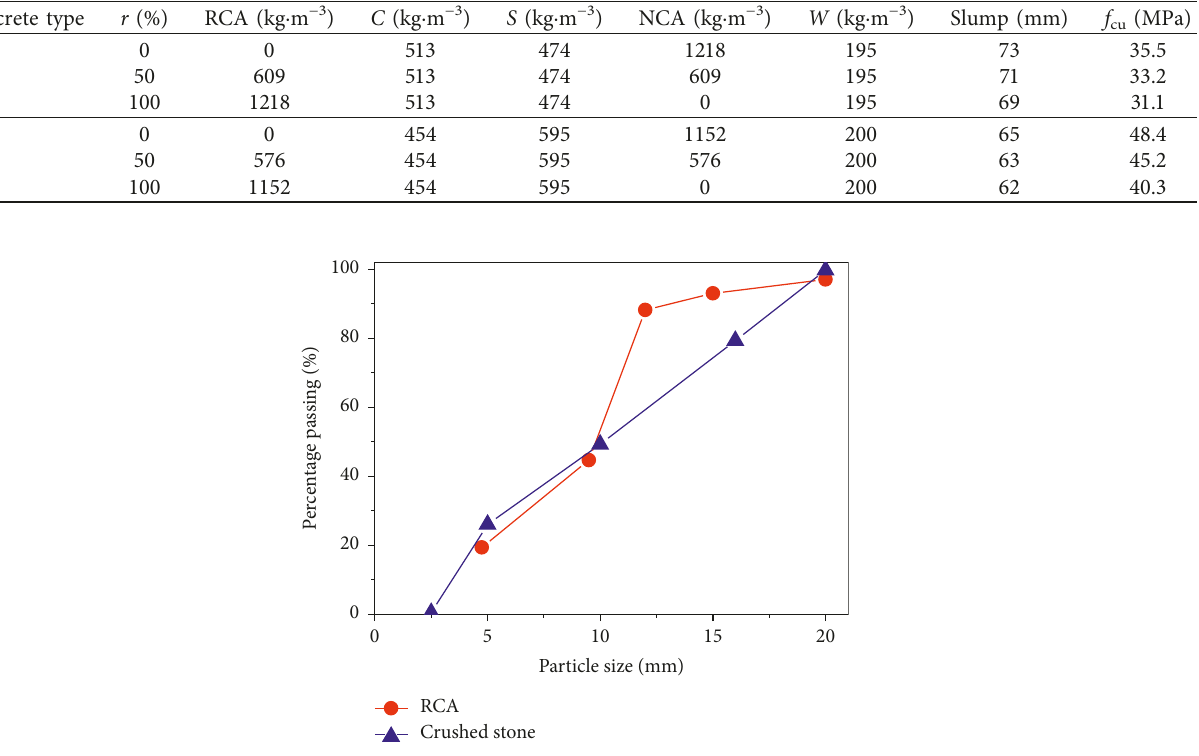
Figure 1: Grading curves of crushed stone and RCA. Table 2: Physical properties of RCA and